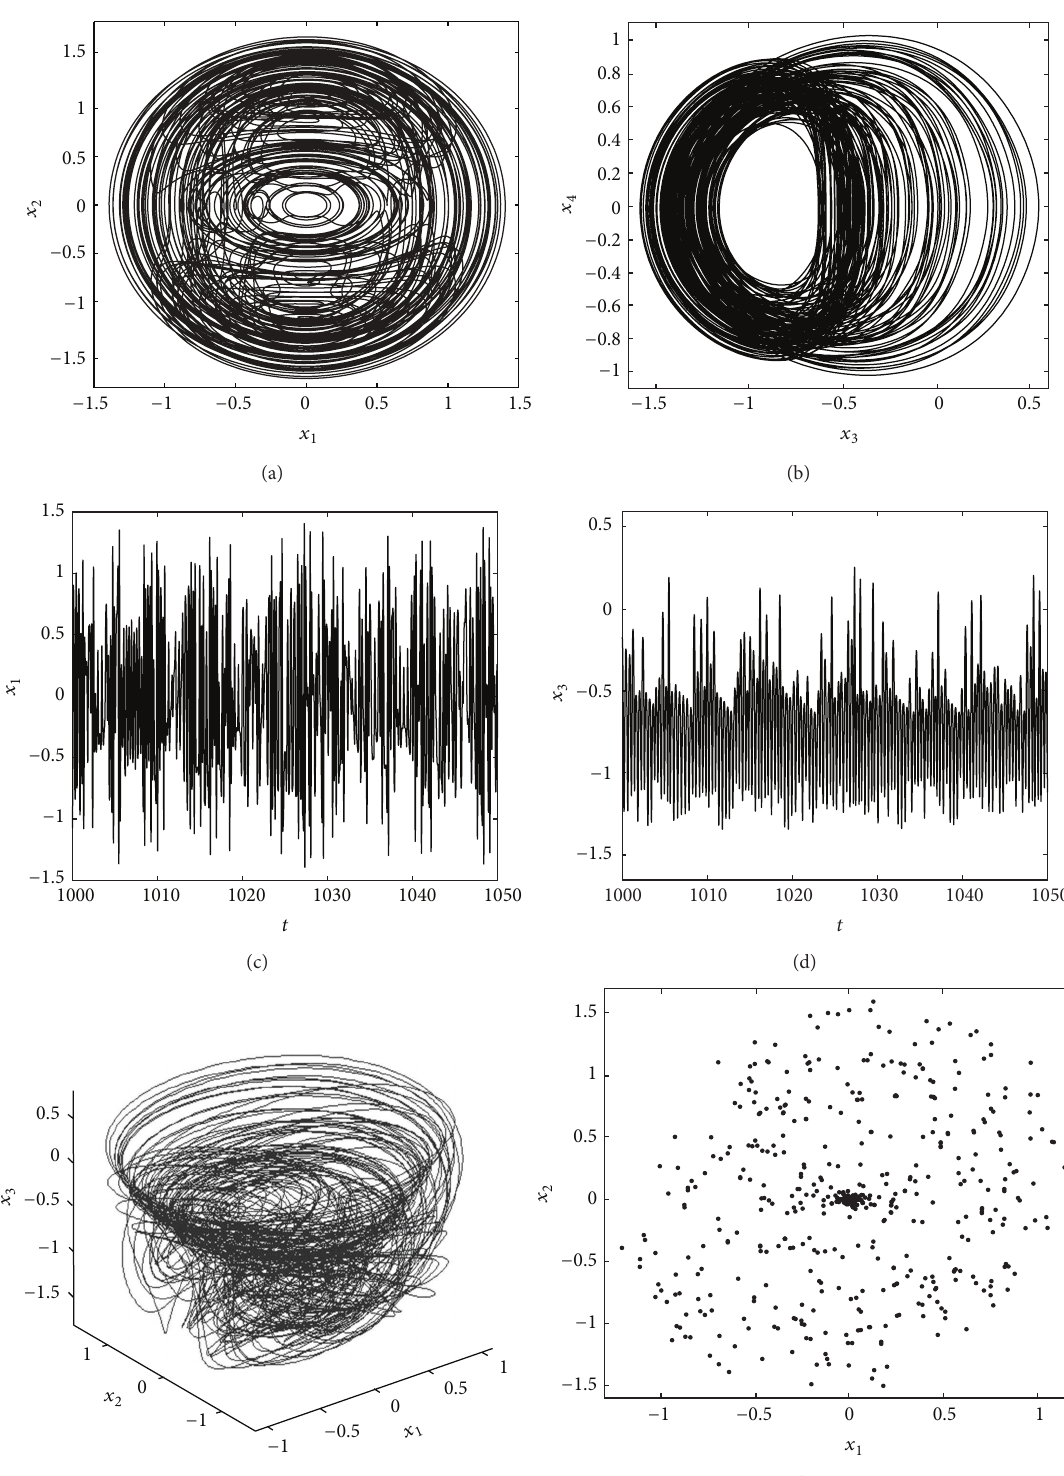
Figure 13: The multipulse chaotic motion is obtained when 𝑎 6 = −17.37 and 𝑏 6 = −13.68 ; (a) the phase portrait on the plane (𝑥 1 , 𝑥 2 ) ; (b) the phase portrait on the plane (𝑥 3 , 𝑥 4 ) ; (c) the waveform on the plane (𝑡,𝑥 1 ) ; (d) the waveform on the plane (𝑡,𝑥 3 ) ; (e) the phase portraits in the three-dimensional space (𝑥 1 , 𝑥 2 , 𝑥 3 ) ; (f) Poincare map on the plane (𝑥 1 ,𝑥 2 )